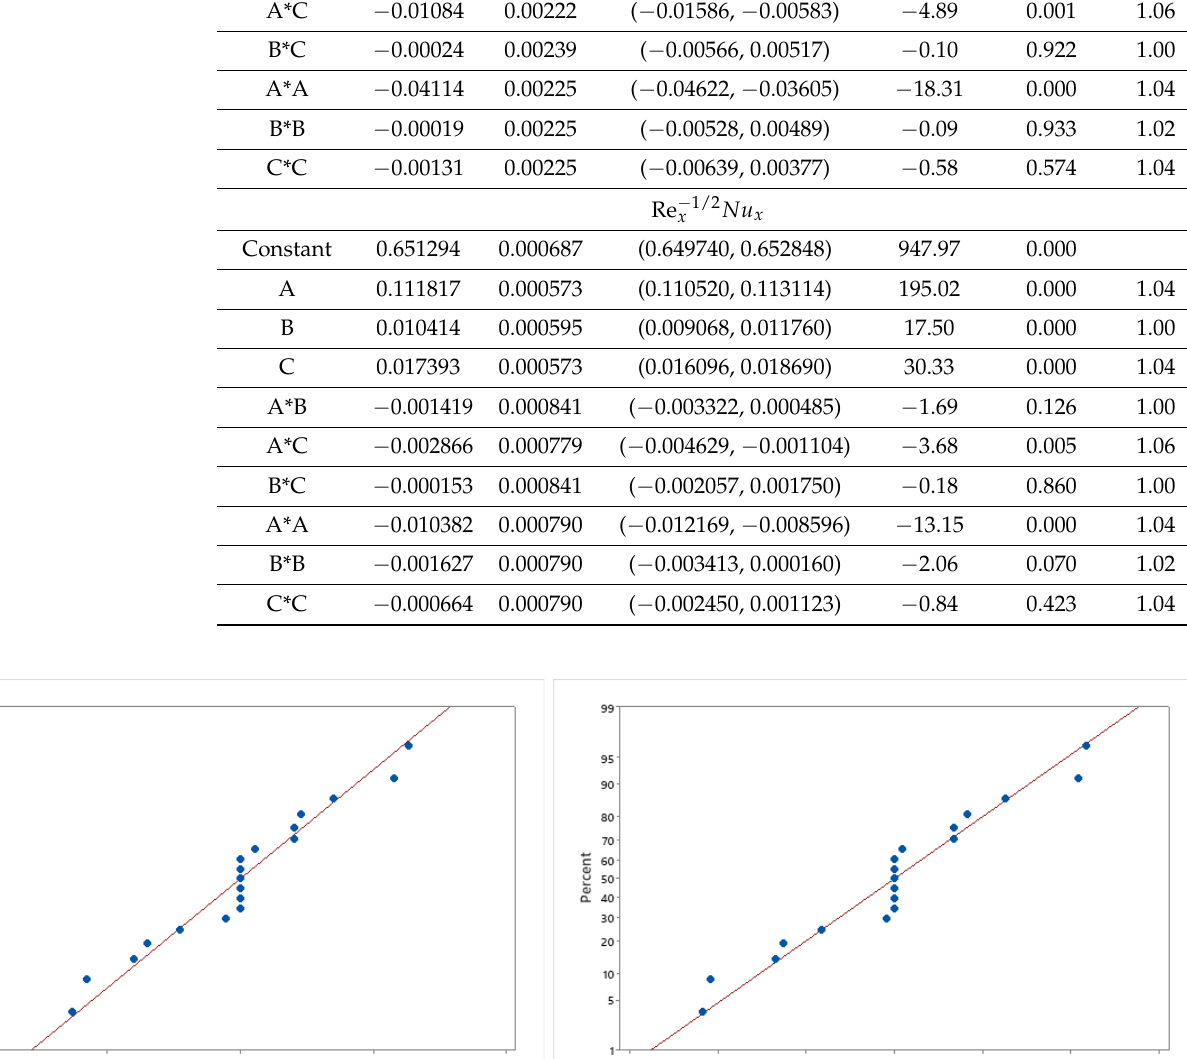
Table 8. Model summary for the responses.